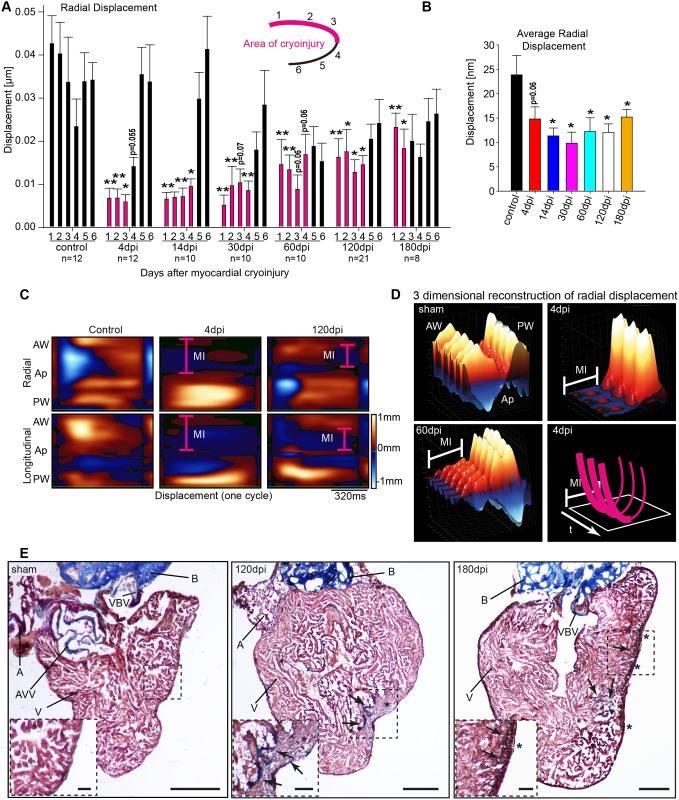
Advanced 2D wall motion measurement by speckle-tracking analysis after cryoinjury reveals segmental and regional motion and deformation disturbances.(A) Absolute radial displacement of individual segments at indicated time points. The ventricle was divided in six segments as indicated with segment 1 and 2 representing the anterior wall (AW), 3 and 4 the apex (Ap), and 5 and 6 the posterior wall (PW) for subsequent displacement analysis. Small numbers indicate number of animals measured. (B) Average of radial displacement at indicated time points. (C) High resolution speckle-tracking analysis of radial (upper row) and longitudinal (lower row) displacement. The top region displays displacement of the AW, the central region of the Ap and the lower region of the PW. Absolute values are color coded with high values in light red and low values in light blue as indicated. Time scale and color coding bar as indicated. The pink line at 4dpi depicts injured area (MI). (D) 3D reconstruction of regional displacement at indicated time points enables identification of akinesis of injured AW at 4dpi and residual wall motion deficiencies at 60dpi, respectively. The lower right image shows a schematic illustration of the 3D-reconstrations. The u-shaped pink lines indicate consecutive systoles; t and the arrow below indicate the time progress and MI the infarcted area, also indicated by the bold pink line. (E) Modified AFOG-staining (myocardium in red, connective tissue and fibrotic areas in blue) stained sections of a sham operated control heart and at 120 and 180dpi. AW is to the right, PW to the left. Boxed area of the cryo-injured region is shown in higher magnification in the lower left corner of its respective overview picture. At 120dpi residual fibrotic deposition (arrows) together with a thickening of the compact myocardial layer (*) can be detected. Residues of fibrosis are still detectable at 180dpi. Note that the thickening of the compact myocardial layer (*) extends over a great segment of the AW. Ap, apex; A, atrium, AVV, atrio-ventricular valve; AW, anterior wall; B, bulbus arteriosus; MI, myocardial injury; PW, posterior wall; V, ventricle; VBV, ventriculo-bulbar valve. Values are expressed as means ± SEM; *, p<0.05; **, p<0.01, unpaired student’s t-test and ANOVA with post hoc comparisons by Bonferroni’s multiple comparison test